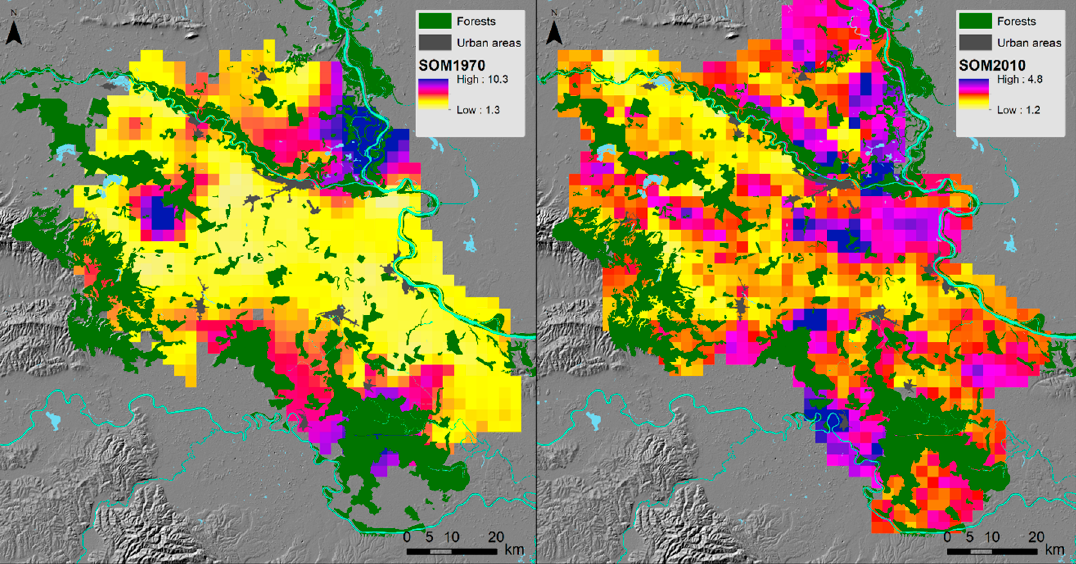
Figure 9. Spatial distribution map of SOM1970 and SOM2010 data using block kriging, with blocks of 2500 m (areas with a prediction standard deviation >0.5% have been blanked).